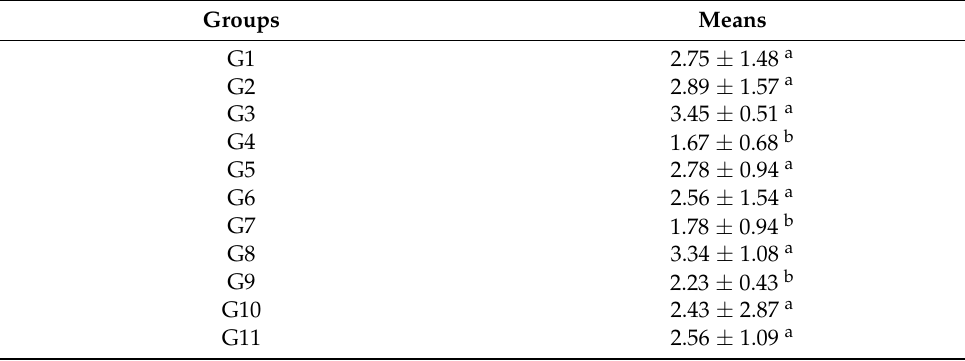
Table 2. Means of the gross lesion score of the different groups. Groups